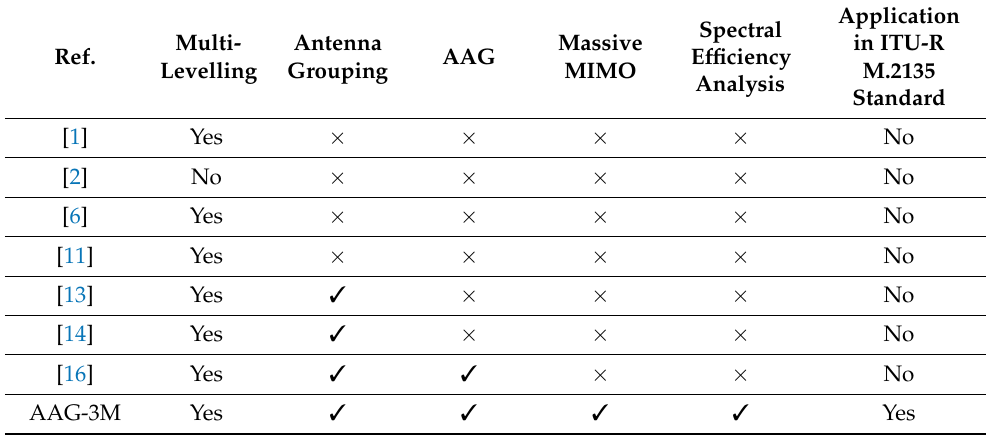
Table 2. Comparative analysis of pre-existing work on space–time coding with the proposed method. Multi- Antenna Ref. Levelling Grouping